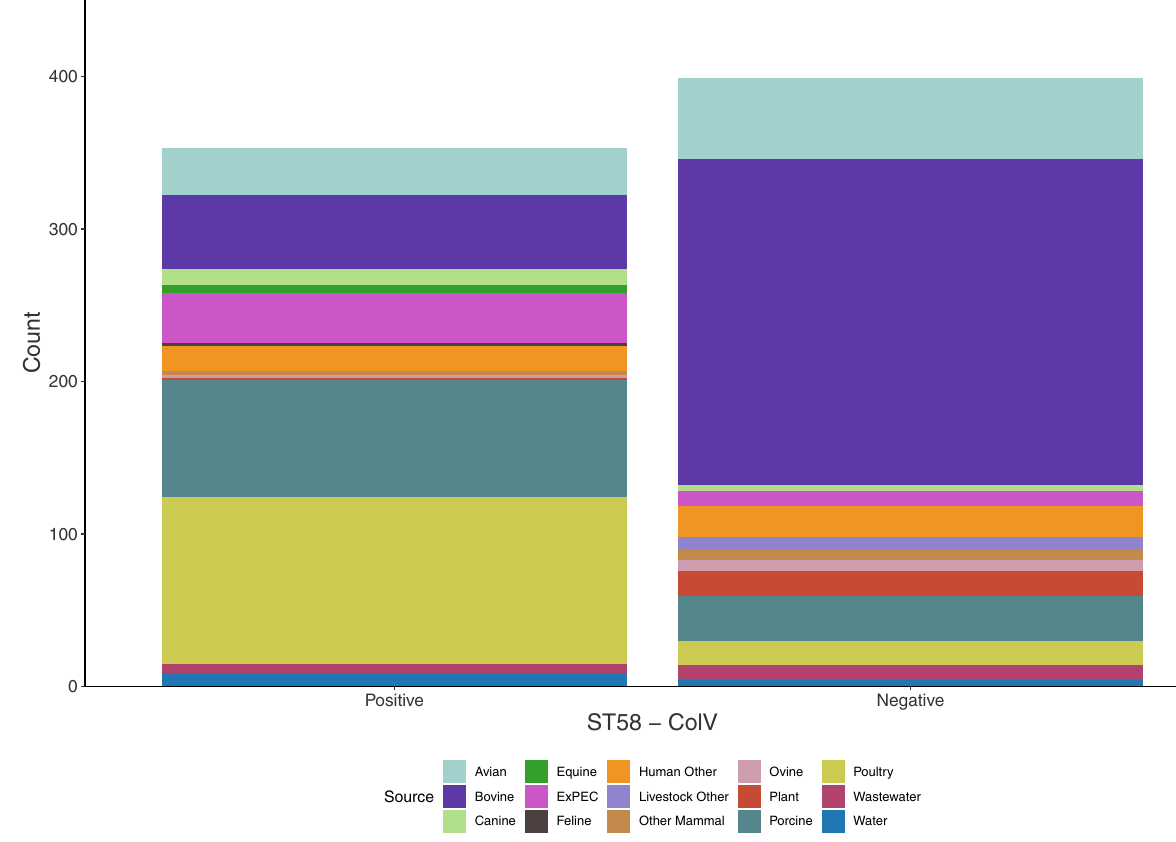
Fig. 5 ColV carriage by source. ColV carriage strati fi ed by source in the ST58 genome